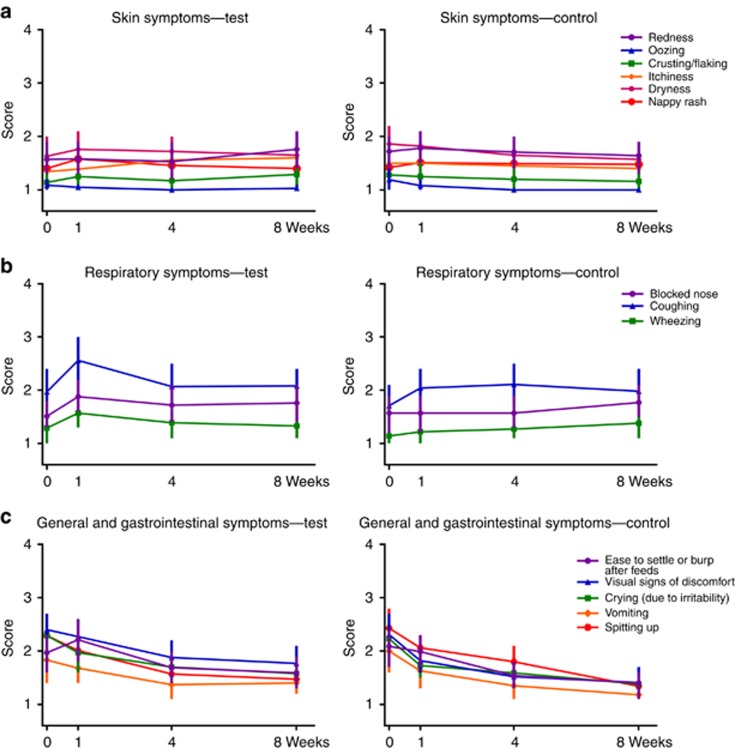
Parent-reported, clinician-evaluated symptoms at weeks 0, 1, 4, and 8 assessed on a 4-point rating scale specific for each symptom. Skin symptoms (redness, oozing, crusting, itchiness, dryness, and nappy rash) were rated as 1: none, 2: slight, 3: some, and 4: a lot. Respiratory symptoms blocked nose and wheezing rated as 1: none, 2: mild, 3: moderate, and 4: severe, and coughing was rated as 1: none, 2: one to two times/day, 3: three to five times/day, and 4: more than five times/day. General and gastrointestinal symptoms: vomiting was rated as 1: none, 2: one to two times/day, 3: three to four days/day, and 4: more than four times/day; spitting-up as 1: none, 2: after some feeds, 3: after all feeds, and 4: between and after feeds; gas/wind as 1: none; 2: slight; 3: some; and 4: a lot; sleep pattern last night as 1: normal, 2: awake once, 3: awake two to three times, and 4: awake more than three times; ease of settling or burping after feeds as 1: no problem at all, 2: slight difficulty, 3: some difficulty, and 4: very difficult; visual signs of discomfort (e.g., back arching) as 1: none, 2: slight, 3: some, and 4: a lot; and crying (because of irritability) as 1: none, 2: up to 1 h, 3: 1–3 h, and 4: more than 3 h. Data are shown as mean values±95% confidence interval limits.